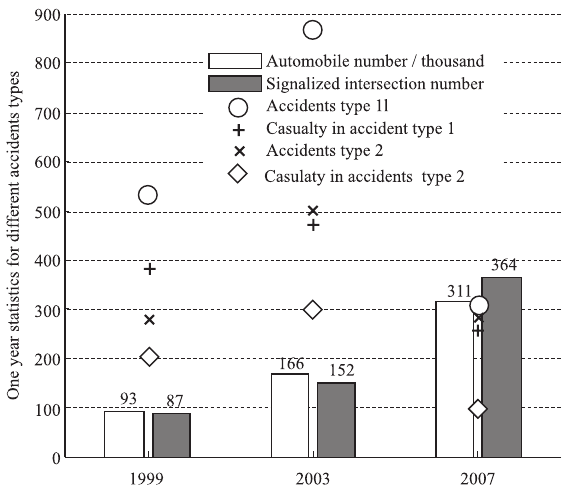
Fig. 2. Accident type categorization for three typical